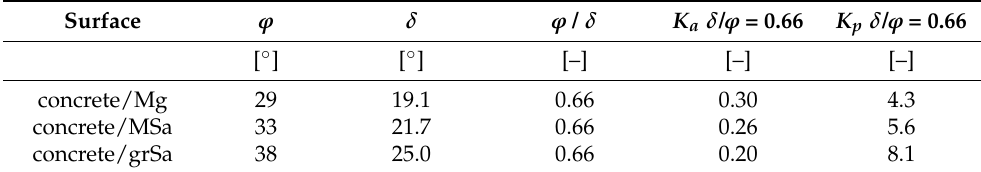
Table 3. Earth pressure coefficient K a , K p, for rough surface according to